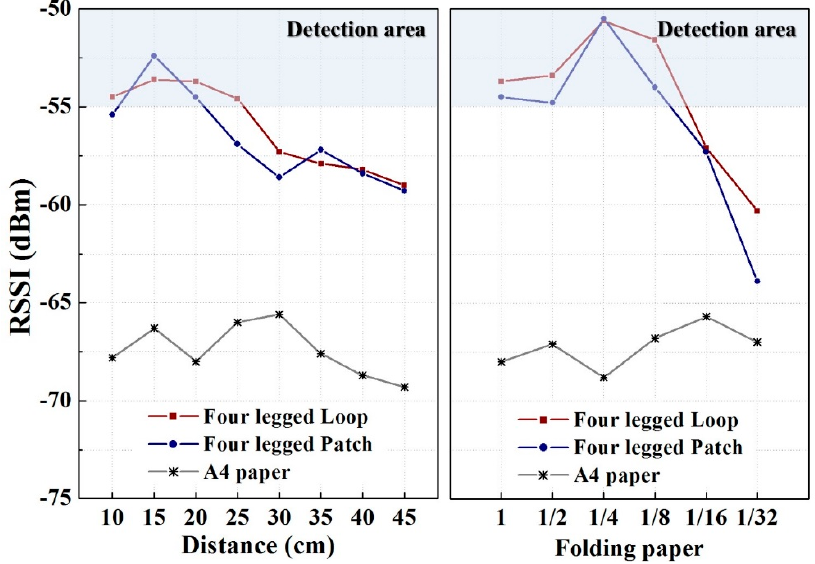
Figure 8. Received signal strength indicators (RSSI) measurement results.